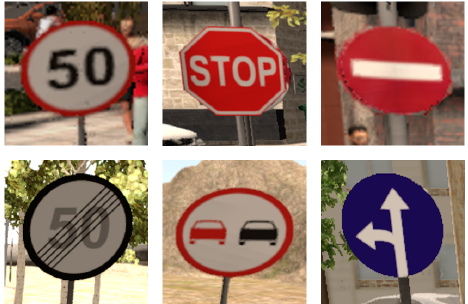
Figure 9. Traffic signs with only a few different meanings can be used to train the traffic sign detector, as there is no larger overlap between a published real and a synthetic dataset (Ros et al.,